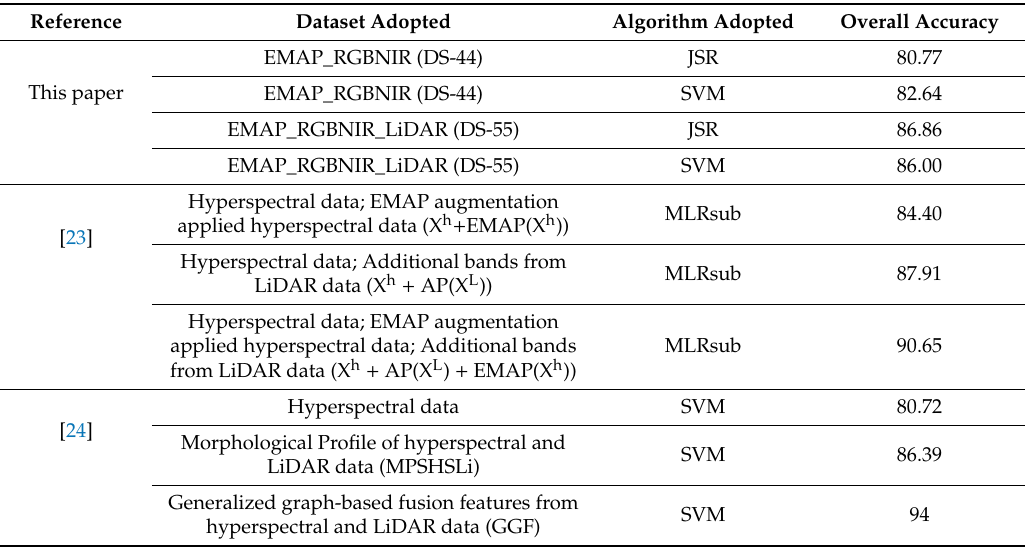
Table 10. Comparison of the overall accuracies (%) of several